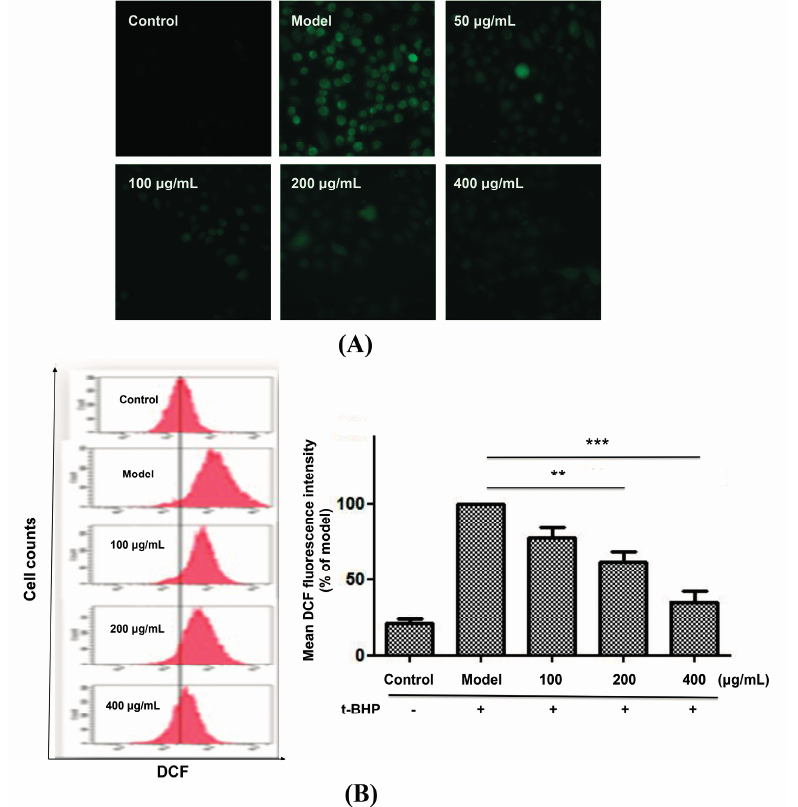
Figure 4. P. chinense extract attenuated t -BHP-induced ROS generation in L02